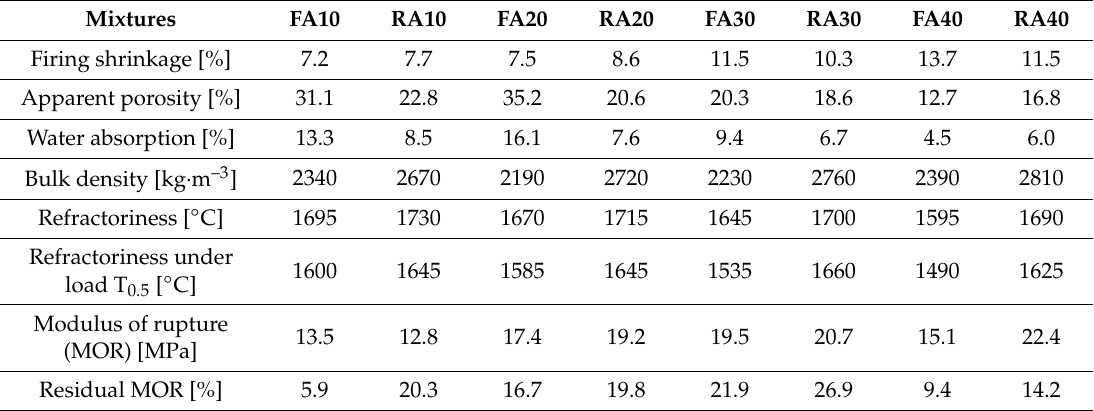
Table 3. The results of the aforementioned experiments for all